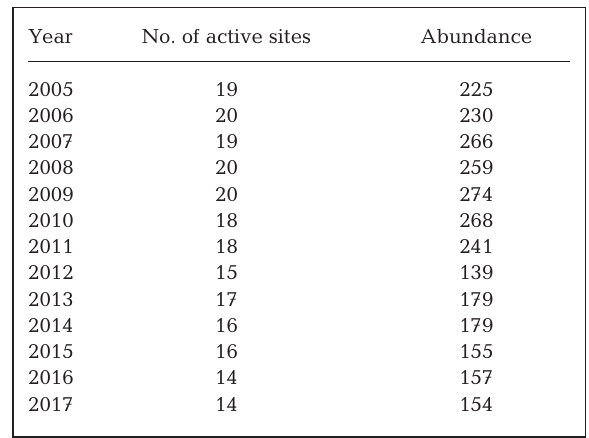
Table 1. Number of active salmon farming sites and sea lice abundance counts for each year in the data set